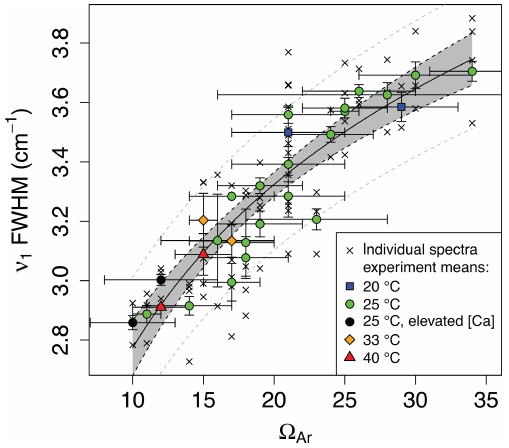
Figure 2. Sensitivity of true ν 1 FWHM to (cid:127) Ar . The x axis rep- resents the mean, and the horizontal error bars represent 1 stan- dard deviation, of (cid:127) Ar while aragonite precipitated in each exper- iment. The crosses indicate individual spectra, the filled points in- dicate means of each experiment, and the vertical error bars repre- sent the standard error of replicate spectra. Colours indicate experi- ments conducted at various temperatures, and black circles indicate the two experiments conducted with elevated [Ca 2 + ]. Grey shad- ing represents the standard error of the curve fit to the individual spectra, and the dashed grey lines represent the standard error of